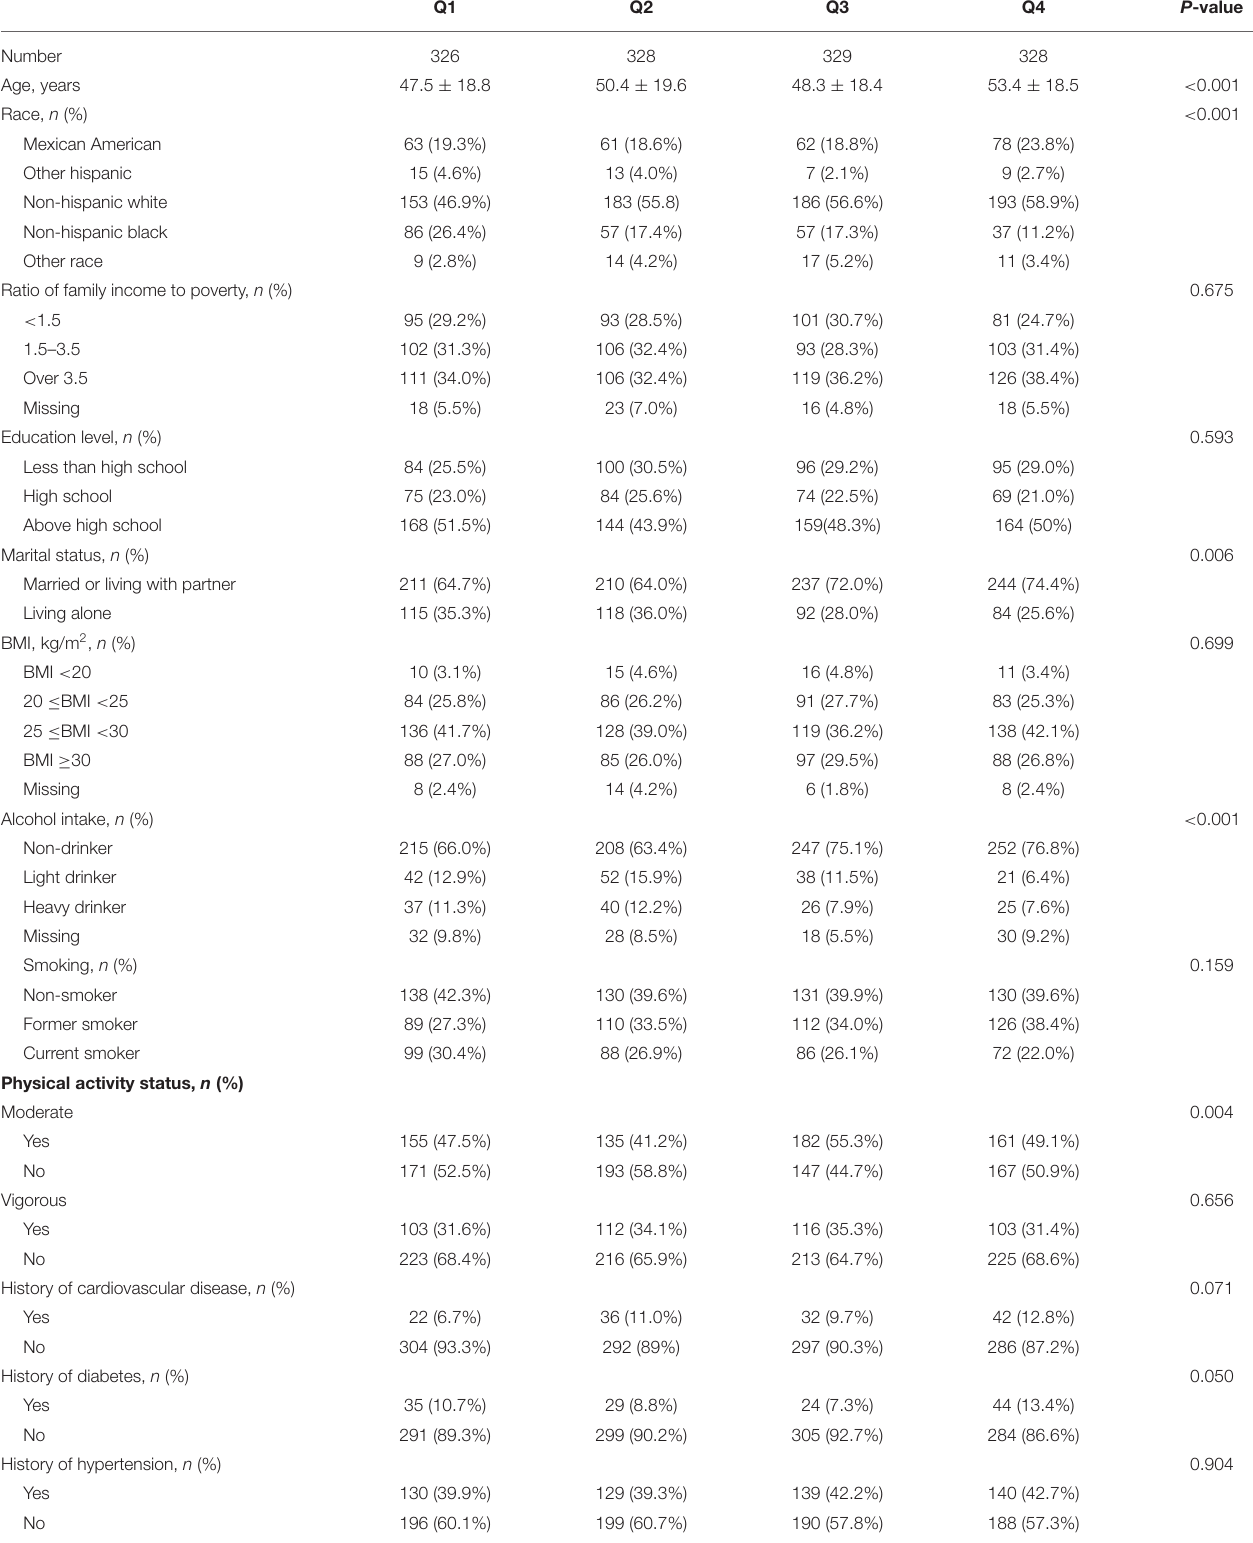
TABLE 1 | Baseline characteristics of the participants in the National Health and Nutrition Examination Survey (NHANES) 2001–2004.